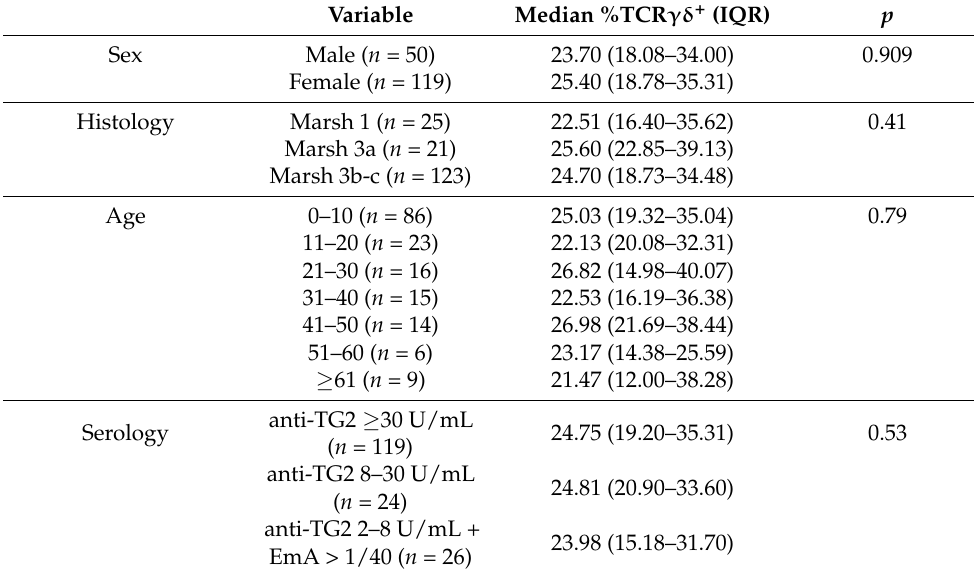
Table 2. Comparison of %TCR γδ + between different groups of sex, age, and degree of